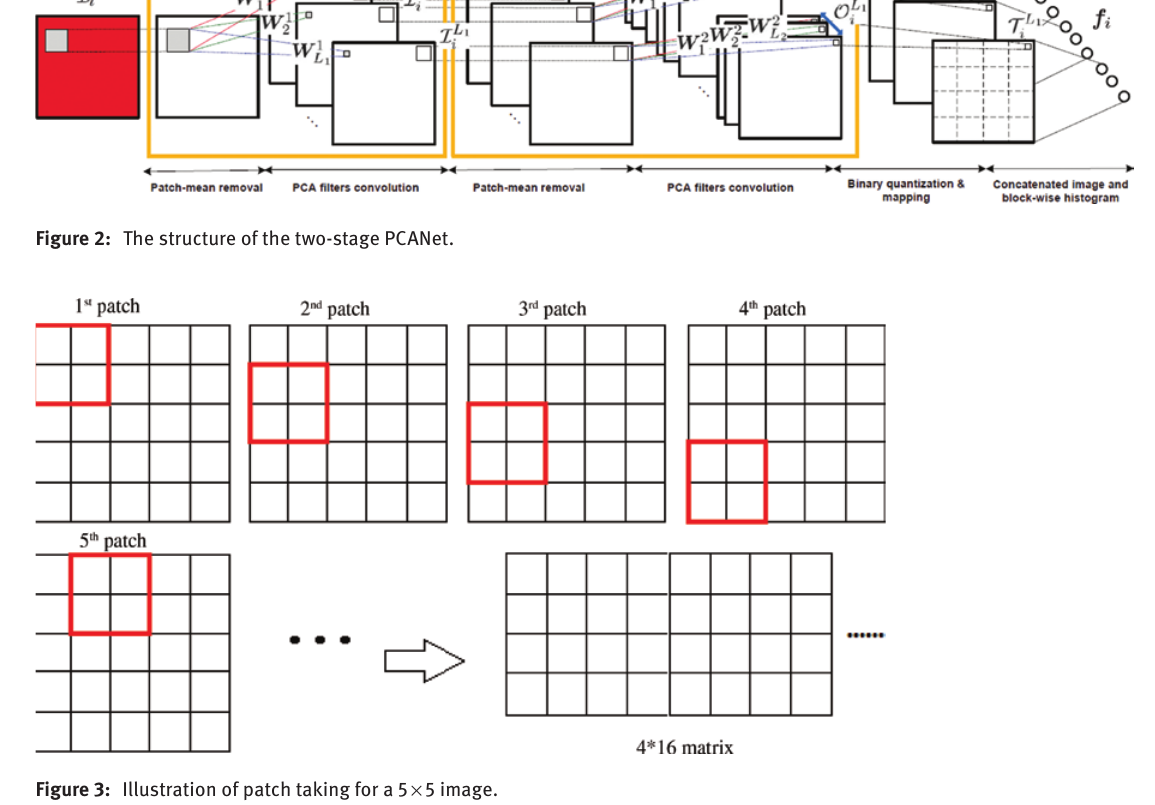
Figure 3: Illustration of patch taking for a 5 × 5